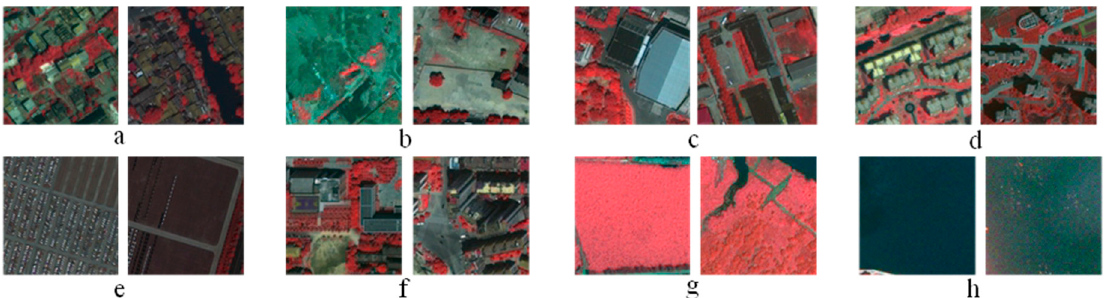
Figure 10. Class representatives of the Wuhan IKONOS dataset: ( a ) dense residential, ( b ) idle, ( c ) industrial, ( d ) medium residential, ( e ) parking lot, ( f ) commercial, ( g ) vegetation, ( h ) water.